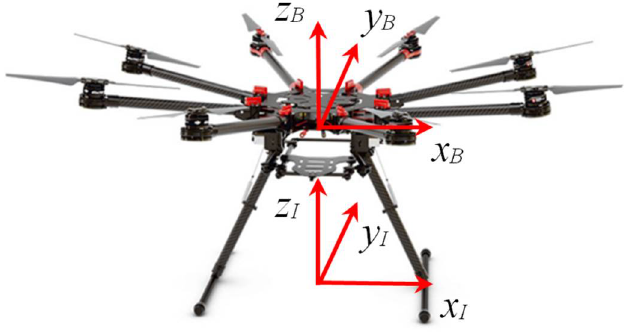
Figure 1. Illustration of reference frames for the UAV system (DJI S1000) [12].